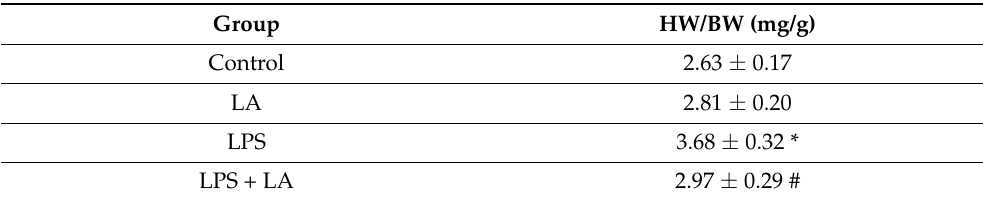
Table 1. Changes in the HW (heart weight)/BW (body weight) ratio in the control, LA, LPS, and LPS + LA groups.